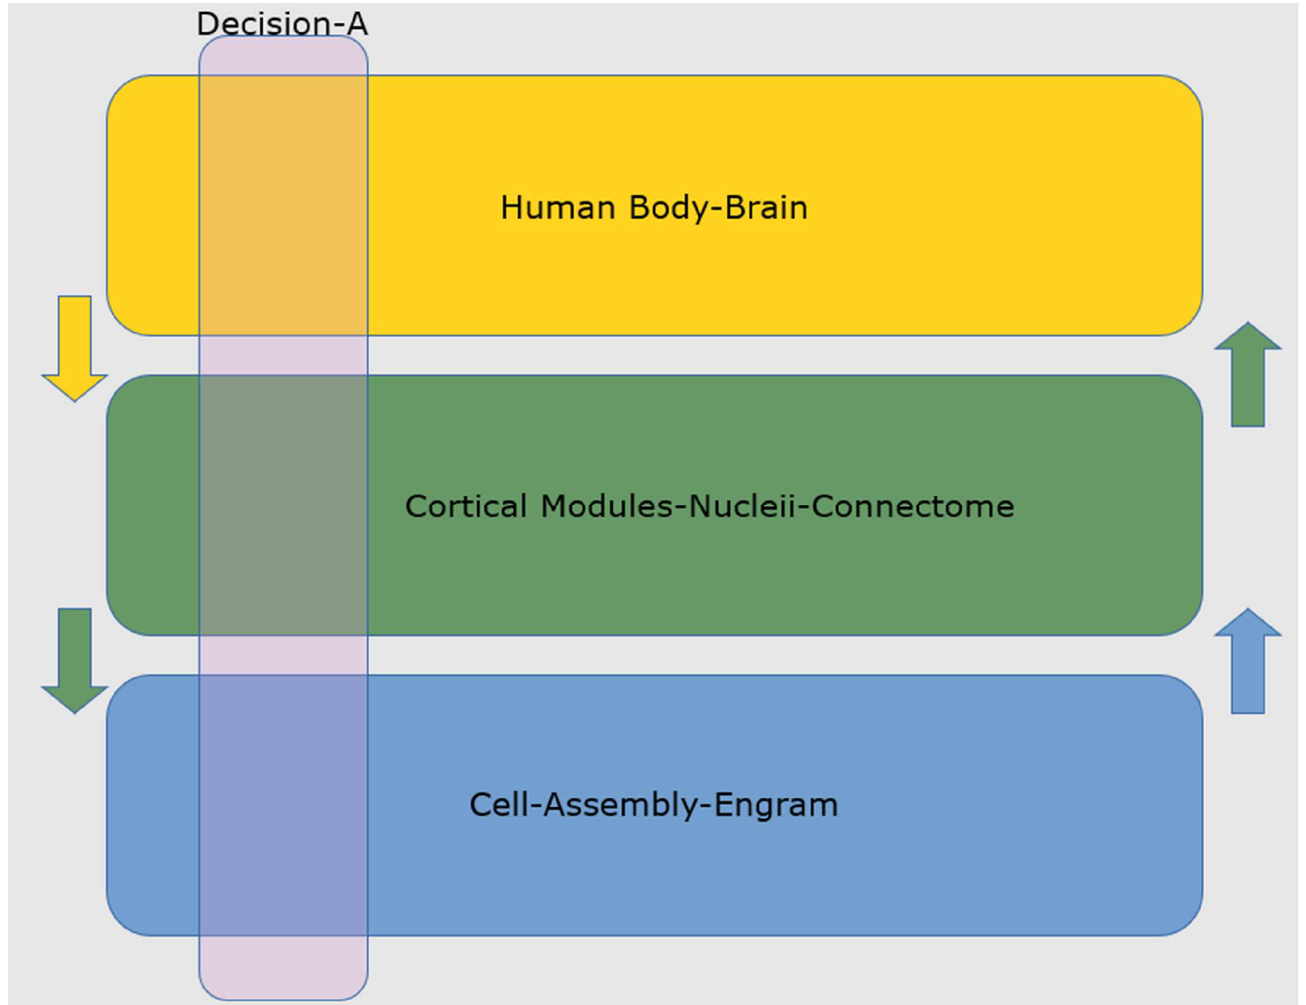
Figure 2. The Human Brain Decision Stack. Primary control flows from the bottom to the top of the stack, albeit with top-down feedback. A set of individual neurons (c. 1000 out of 10 11 ) make up a cell assembly representing a perception, concept, memory, or decision. The synchronous behavior of the cell assembly results in specific activations in brain cortical modules and nuclei via short-range and long-range axonal connections, known as the connectome. Those activations produce a cognitive response in the human body-brain, manifesting as decisions and human behaviors.